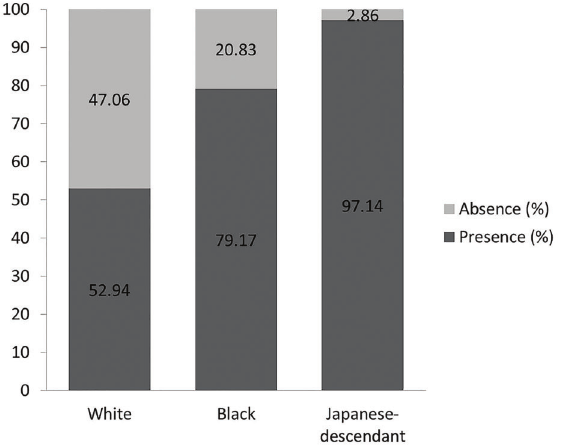
Figure 2. Frequency of t(14;18) translocation in different ethnic groups, as determined by nested-PCR. The X 2 -test was used to demonstrate differences between